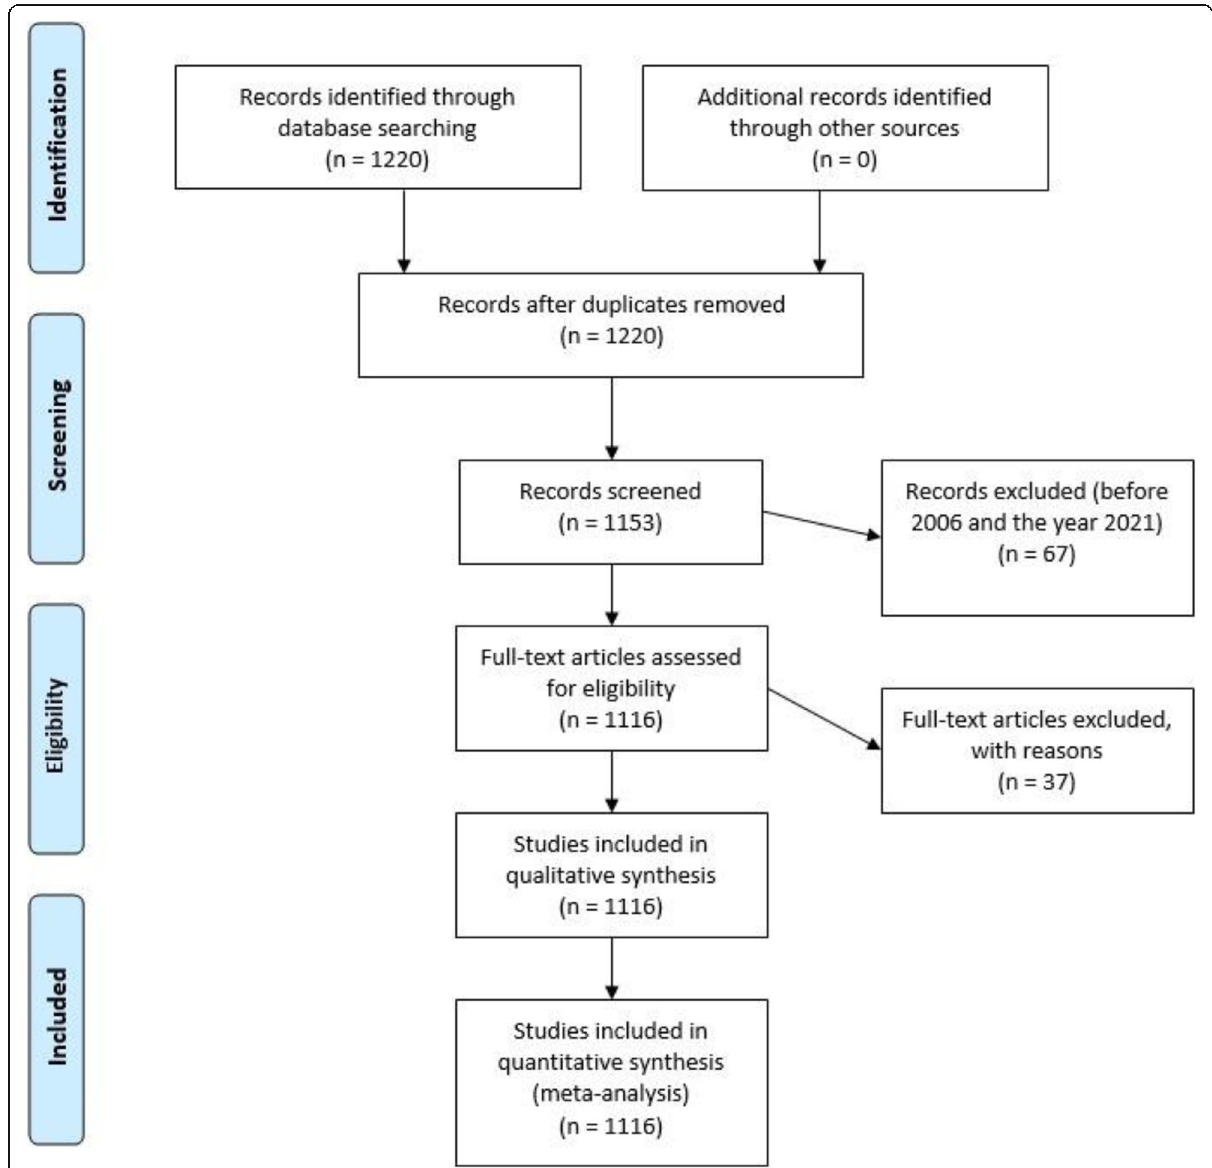
Fig. 1 Flowchart according to the PRISMA